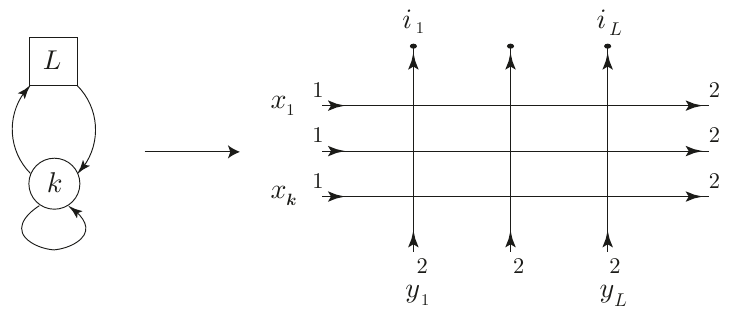
Figure 3 . The su (2) lattice configuration which describes the orbifold defect (4.8) for the A 1 quiver. Here k ≤ L , and the indices i ℓ ∈ { 1 , 2 } , ℓ = 1 , . . . , L , represent spin-states, or equivalently, colours